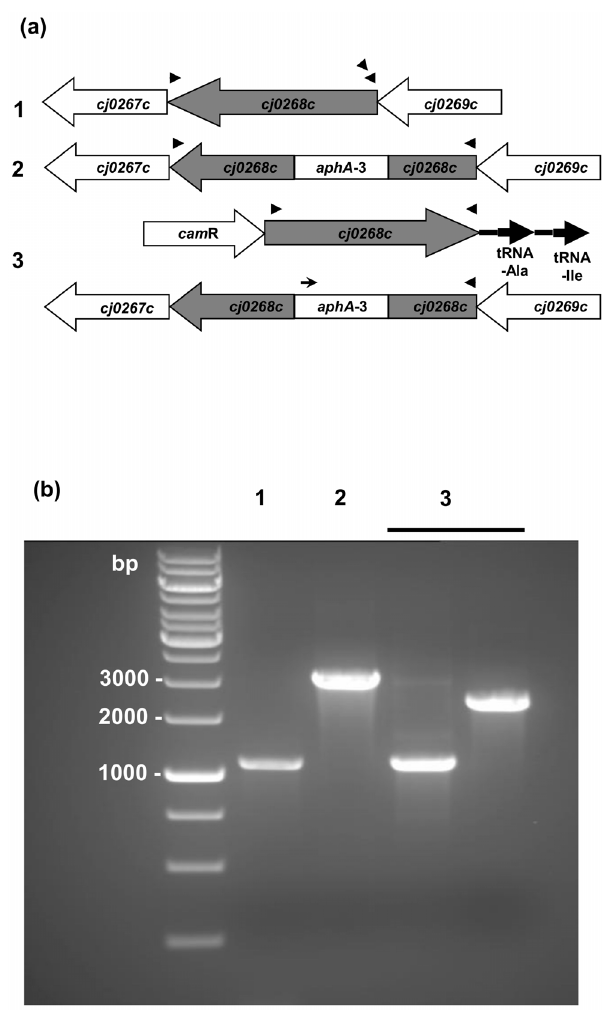
Figure 1. Generation of a cj0268c -knockout mutant and a complemented mutant in C. jejuni strain NCTC 11168. (1) parental strain NCTC 11168, (2) cj0268c knockout mutant (NCTC 11168:: cj0268c ), (3) complemented knockout mutant (NCTC 11168:: cj0268c- comp- cj0268c ). (a) Genome arrangements of the bacte- rial strains under investigation. Primers Cj0268cF and Cj0268cR for the amplification of cj0268c are indicated by arrowheads. The primer KanF that binds to the 5 9 -end of the kanamycin resistance cassette is shown by an arrow. (b) Verification of the native gene, the respective mutant and the complemented mutant strain by PCR. (1) PCR analysis with Cj0268cF + Cj0268cR-primers detect the native gene of 1090 bp. (2) aphA-3 insertion in gene cj0268c mediating kanamycin resistance in mutant strain NCTC 11168:: cj0268c was verified by the amplification of a 2914 bp PCR- amplicon applying primers Cj0268cF + R. (3) the comple- mented mutant was verified by PCR analysis with primers Cj0268cF + R to detect the native gene (1090 bp) and with primers KanF + Cj0268cR which amplify a PCR product of 2168 bp. doi:10.1371/journal.pone.0081069.g001 blood agar plates. The bacteria were resuspended in distilled water and adjusted to an OD 600 nm of 0.1. Triton X-100 was added to a final concentration of 1.0%, and after incubation for one hour at